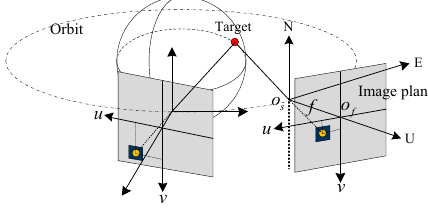
Figure 1. Coordinate system.